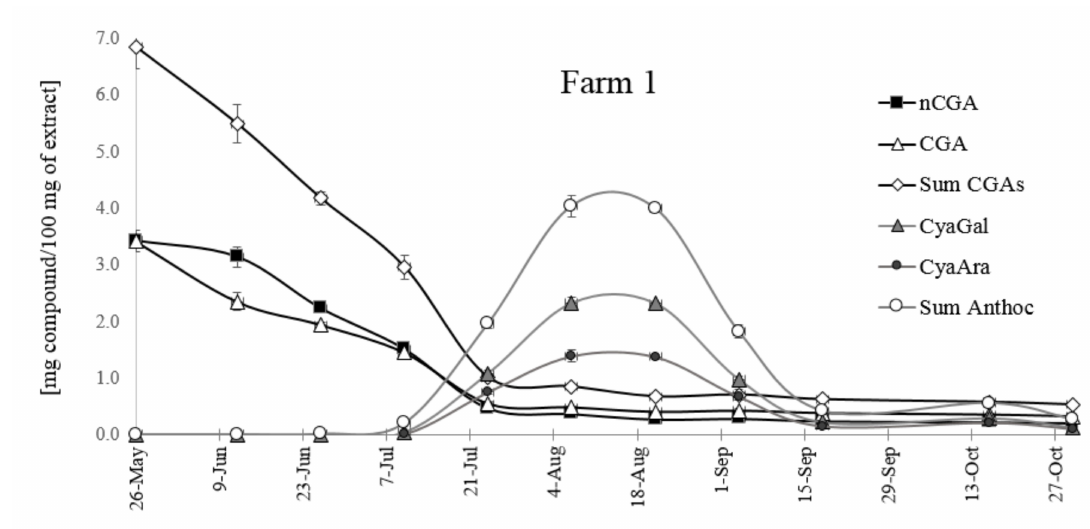
Figure 8. The changes of the CGA and anthocyanin contents from May to October in the fruit from central Poland (farm 1).